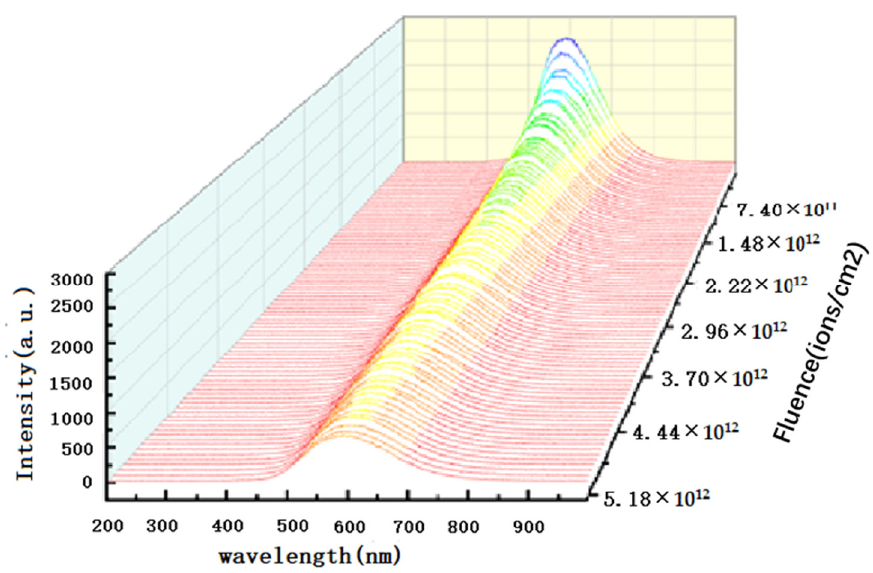
implantation makes the optically active centers gather into small defect clusters, and the clusters gradually aggregate into larger clusters or transform, which leads to a decrease in in 3C-SiC at room temperature with the MD code PARCAS and believed many vacancy and interstitial defects are annihilated along the ion path due to the high temperature. in the center of the incident ion path. Hence, the change in luminescence intensity is a competitive result of the two effects [23].